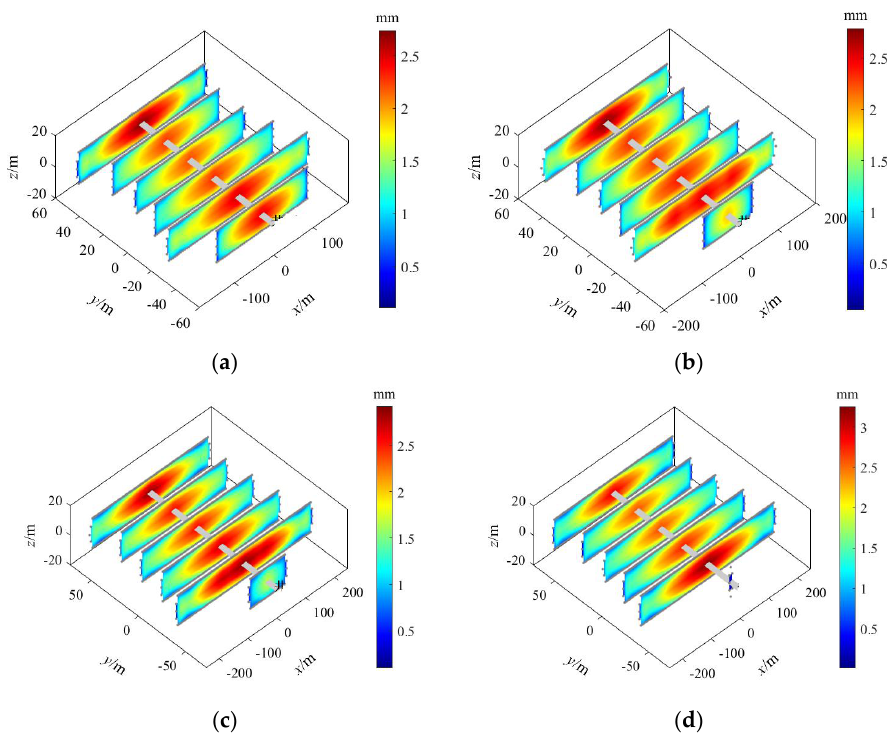
Figure 6. Multi-crack propagation pattern under different stress differences between clusters. ( a ) 1 MPa; ( b ) 2 MPa; ( c ) 3 MPa; ( d ) 4 MPa.